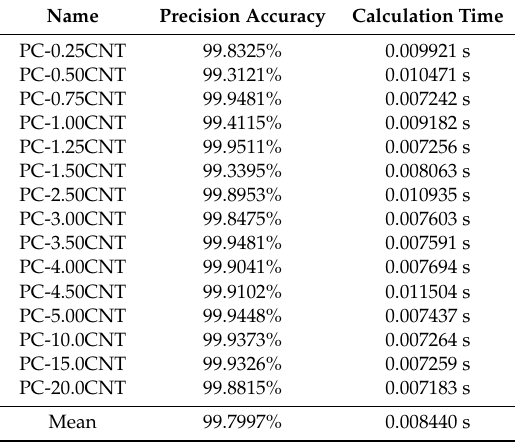
Table 2. The precision of our system applied to di ff erent neural